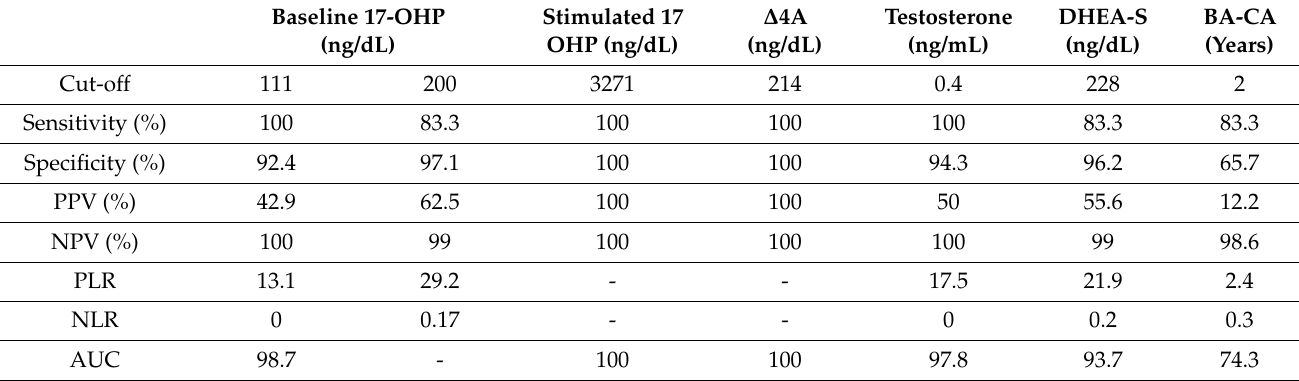
Table 5. Sensitivity, specificity, positive likelihood ratio (PLR), negative likelihood ratio (NLR), positive predictive value (PPV), and negative predictive value